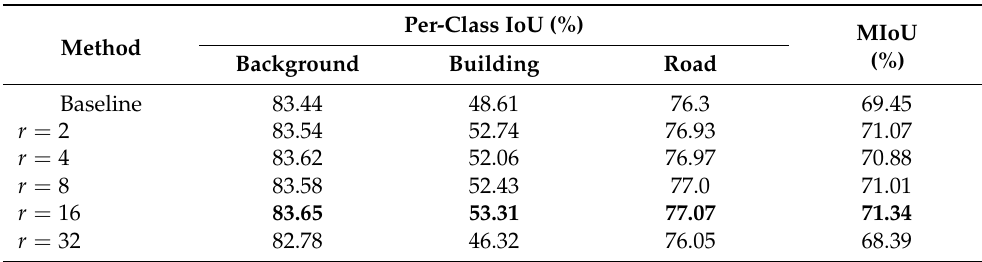
Table 1. Comparison of dimensionality reduction rates of strip attention modules based on the CITY-OSM dataset. (Data in bold are the best results.).